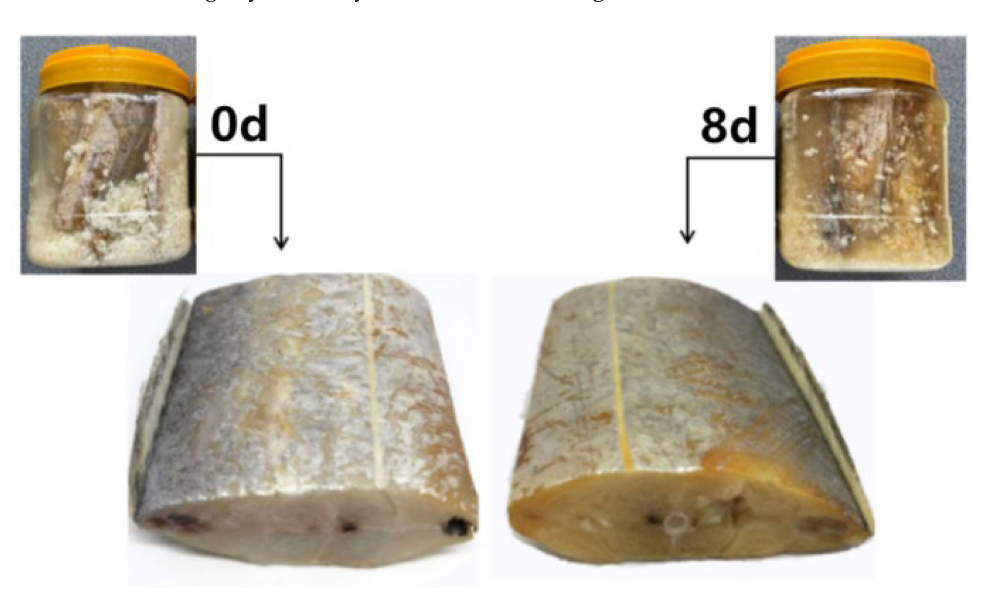
Figure 2. Macrostructure of vinasse hairtails muscle tissues with different